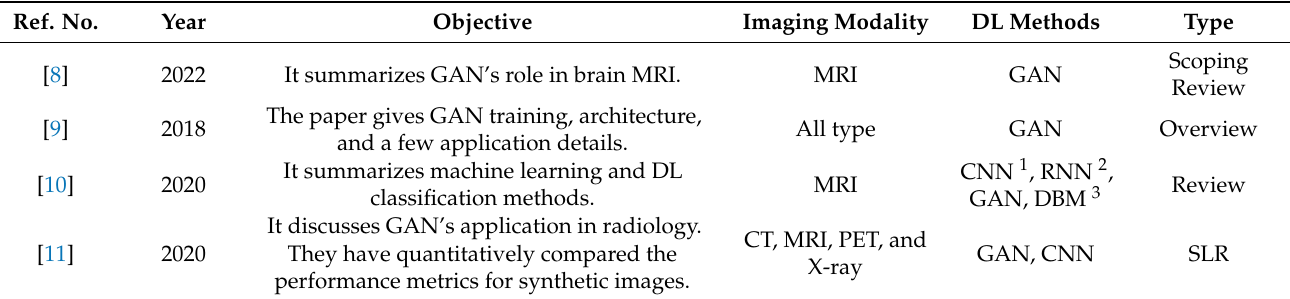
Table 1. Prior research in MRI brain